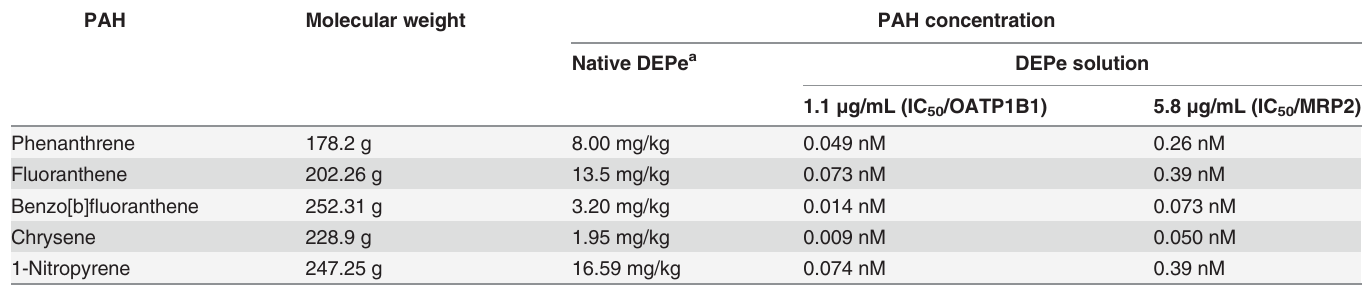
Table 1. Concentrations of selected PAHs in native DEPe and DEPe solutions.